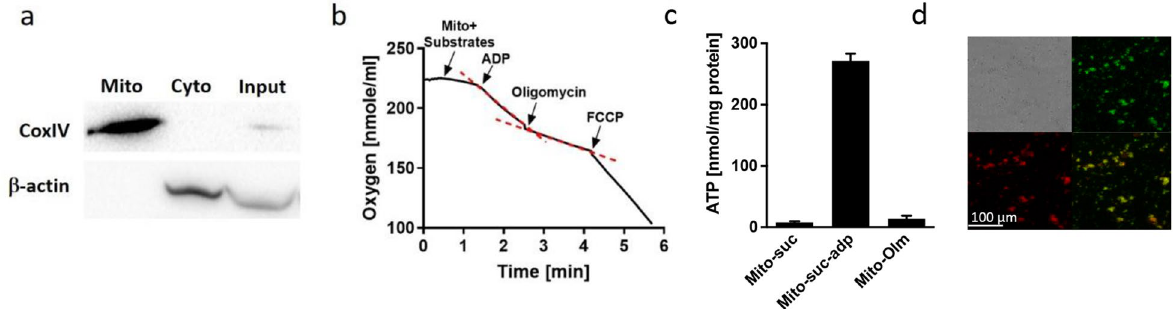
Figure 1. Mitochondrial isolation and characterization. Mitochondria were isolated from mouse liver. ( a ) Western blot analysis showing a clean mitochondrial fraction (mito), enriched with the mitochondrial marker CoxIV and depleted of the cytosolic marker β-actin, which appears in the cytosolic fraction (cyto). Both markers appear in the input sample (before fractionation). ( b ) Oxygen level measurement showing increased consumption after addition of mitochondrial substrates (10 mM Succinate, 1 mM Malate and 5 mM Sodium Pyruvate) and 3 mM ADP, decreased rate after addition of 3.3 µM Oligomycin and maximal consumption after addition of 10 µM FCCP. Red dotted lines exemplify the slope of the reaction. ( c ) ATP levels are increased following addition of ADP substrate (Mito-ADP) and decreased when ATP-synthase inhibitor oligomycin is added (Mito-Olm). Mitochondria alone showed base-line ATP production (Mito-suc). ( d ) Isolated mitochondria were stained with MTR, a marker for active mitochondria (with appropriate membrane potential, red) and with MTG, a marker for pan mitochondria (green). Almost all mitochondria were stained with both dyes, indicating existent membrane potential.